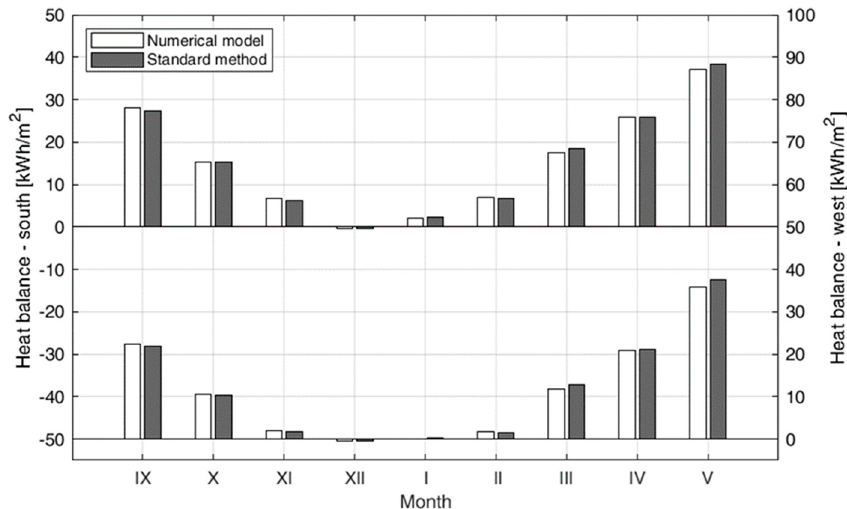
Figure 6. Comparison of results obtained using the standard method and a numerical model for Koszalin (top—south orientation and bottom—west orientation).